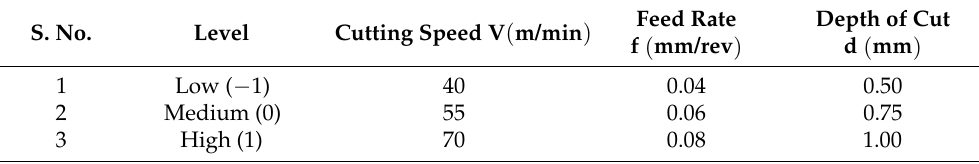
Table 1. Cutting parameters and their